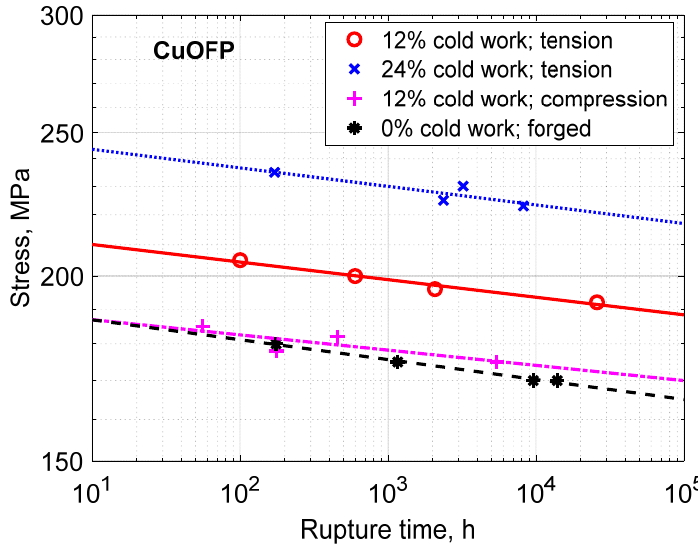
Figure 7. Stress versus rupture time for 12% and 24% cold deformed Cu-OFP at 75 °C. For comparison, data for material without cold deformation is included. The lines are fitted to the experimental data to illustrate the influence of rupture time. Experimental data from [3].